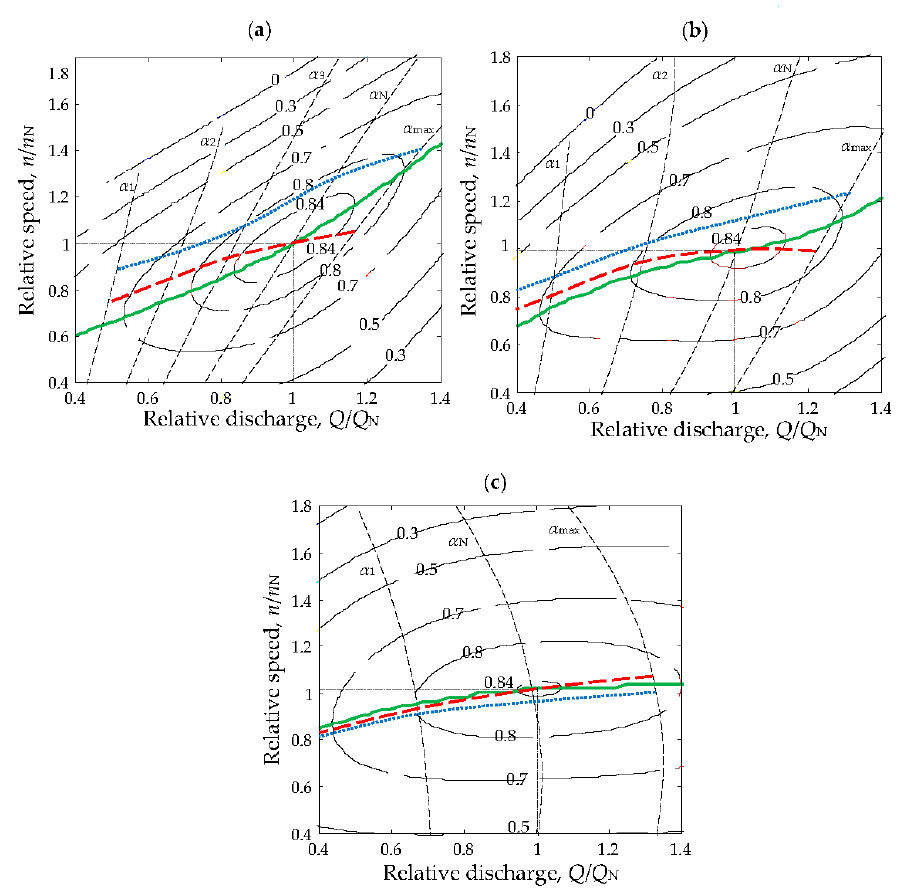
Figure 3. Hill charts of a ( a ) fast turbine, ( b ) normal turbine and ( c ) slow turbine showing the optimal operating curve (green solid line), maximal efficiency for a given angle (red dashed line) and maximal power for a given angle (blue dotted line).